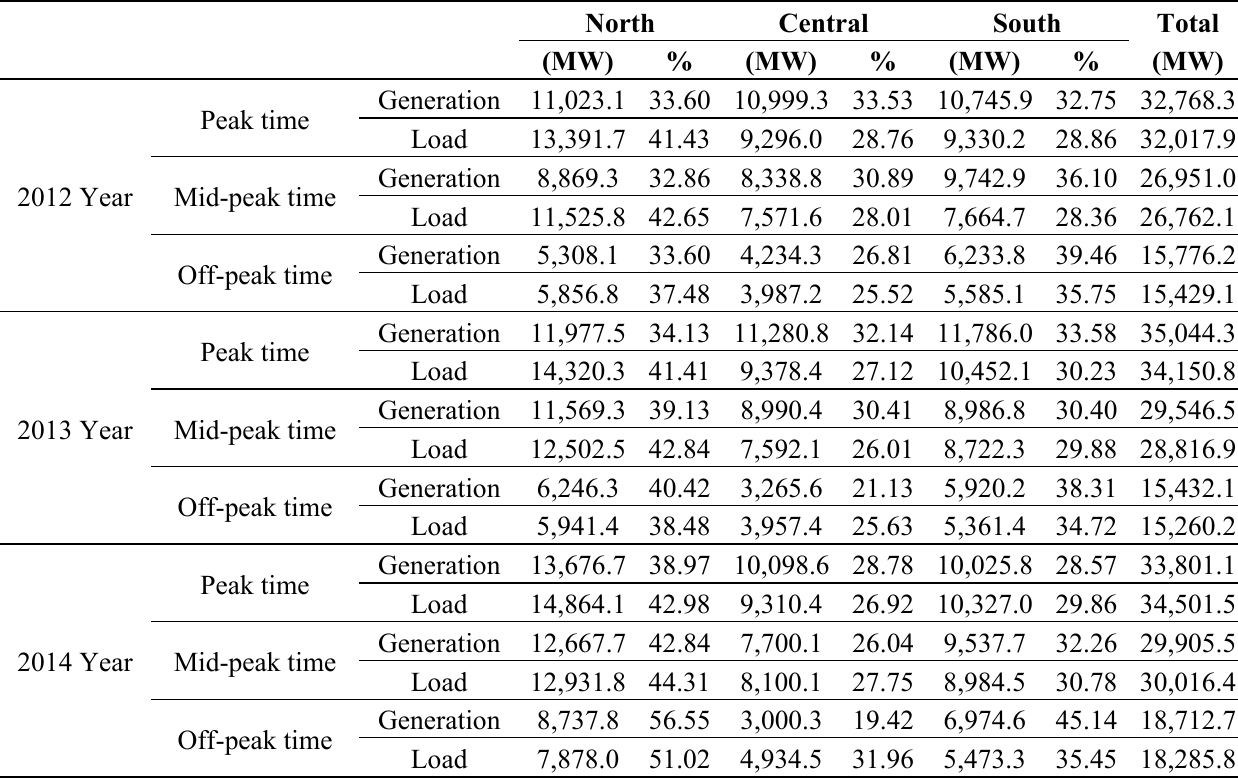
Table 3. The distribution of generation and load from 2012 to 2014 in Taiwan power